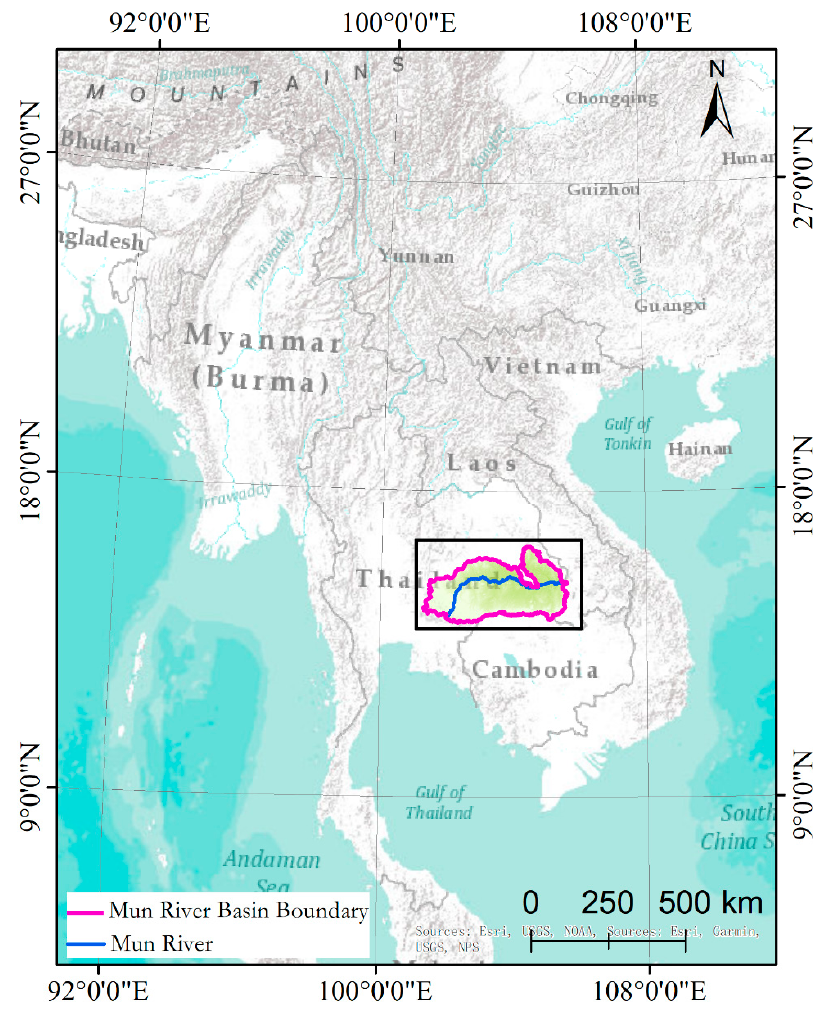
Figure 3. Location of the Mun River Basin test site in northeastern Thailand.